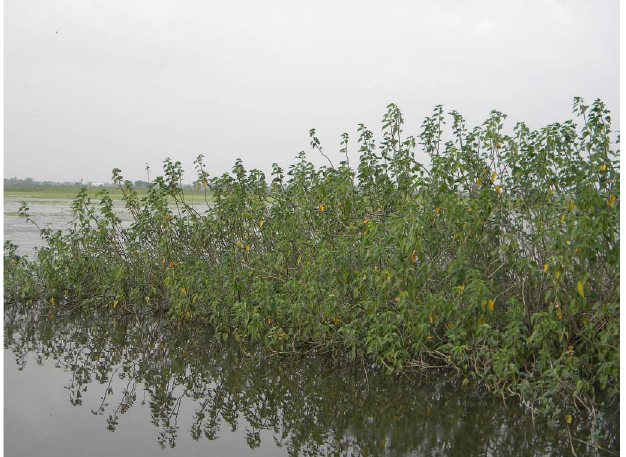
grows throughout the year in and around